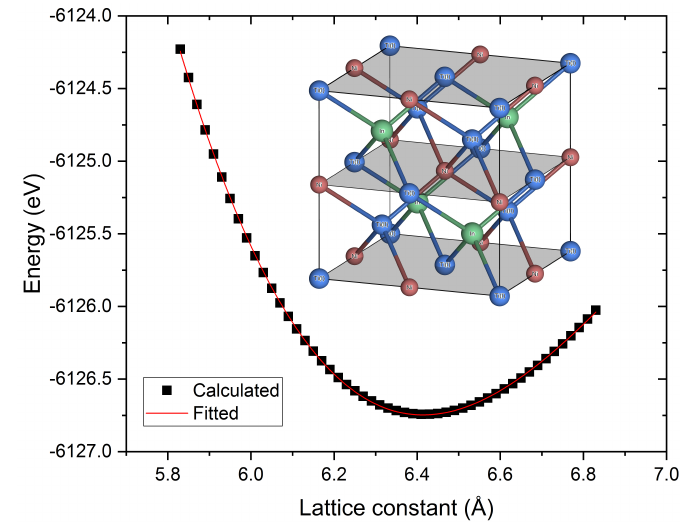
Figure 1. The calculated total energy of Ti 2 NiIn compound with respect to different lattice constant. Inset is the corresponding crystal structure.